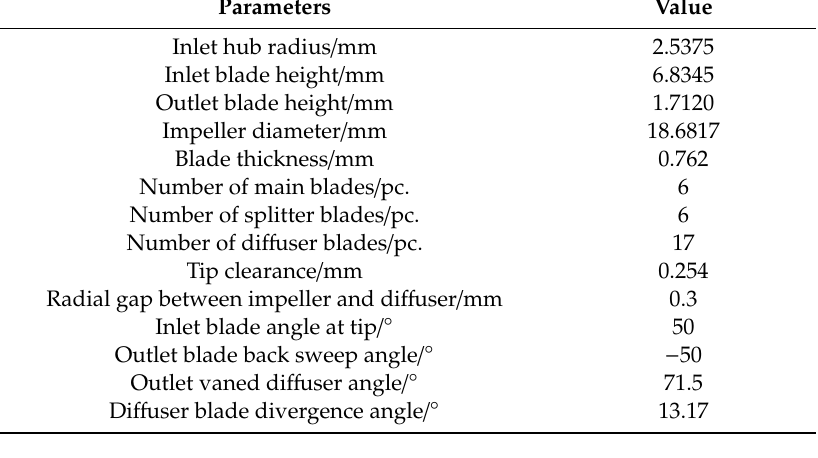
Table 4. The geometric parameters of the SNL S-CO 2 centrifugal compressor [5].